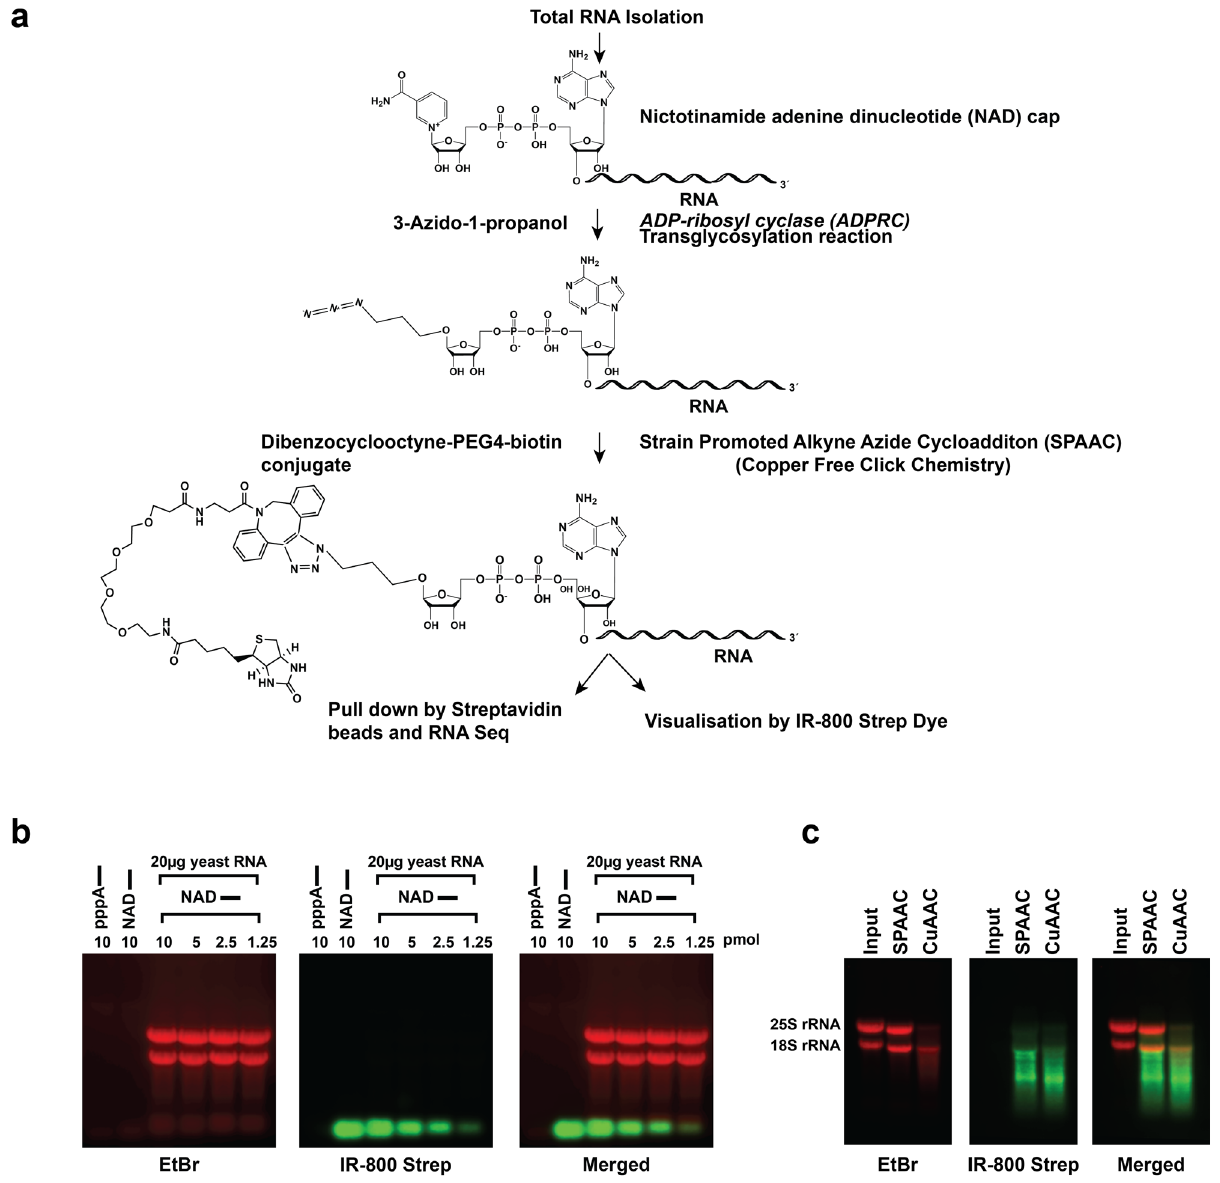
Fig. 1 SPAAC chemistry is superior to CuAAC for characterizing NAD-capped RNAs. a Schematic illustration of the SPAAC reaction to pro fi le NAD- capped RNAs. b Ten picomoles of 40 nts in vitro transcribed RNA with a 5 ′ triphosphate (pppA) or 5 ′ NAD cap were subjected to the SPAAC reaction. The RNAs were resolved on an agarose gel at the indicated concentration either without or with the addition of 20 µ g of background total yeast RNA and transferred onto a Nitrocellulose membrane. The biotin-conjugated RNAs (NAD) were visualized by near-infrared (IR) IRDye ® 800CW streptavidin-based detection using Odyssey Fc (Li-Cor Biosciences). The NAD cap or uncapped RNA is represented by the NAD of pppA followed by a line that denotes the RNA. c Twenty micrograms of total yeast RNA were subjected to SPAAC and CuAAC reactions and the RNAs were detected using IRDye ® 800CW. The CuAAC reactions led to RNA degradation while the SPAAC reactions minimally affect the integrity of the